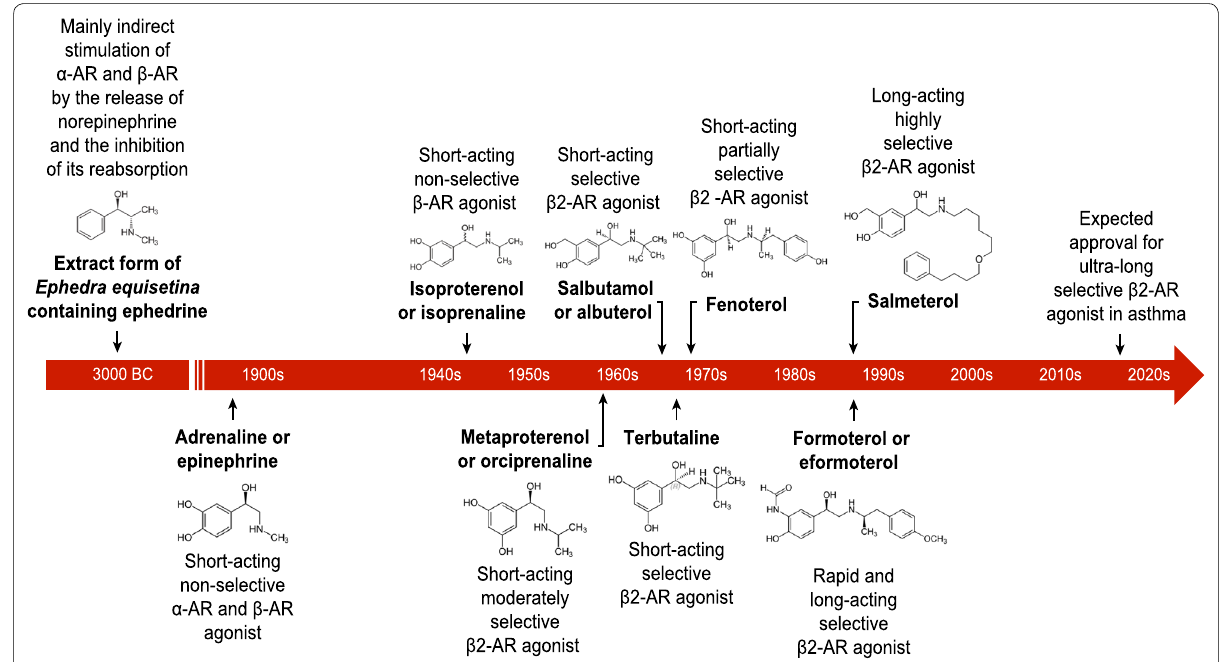
Fig. 1 Timeline for the introduction of adrenergic receptor agonists in asthma treatment [2–16]. AR